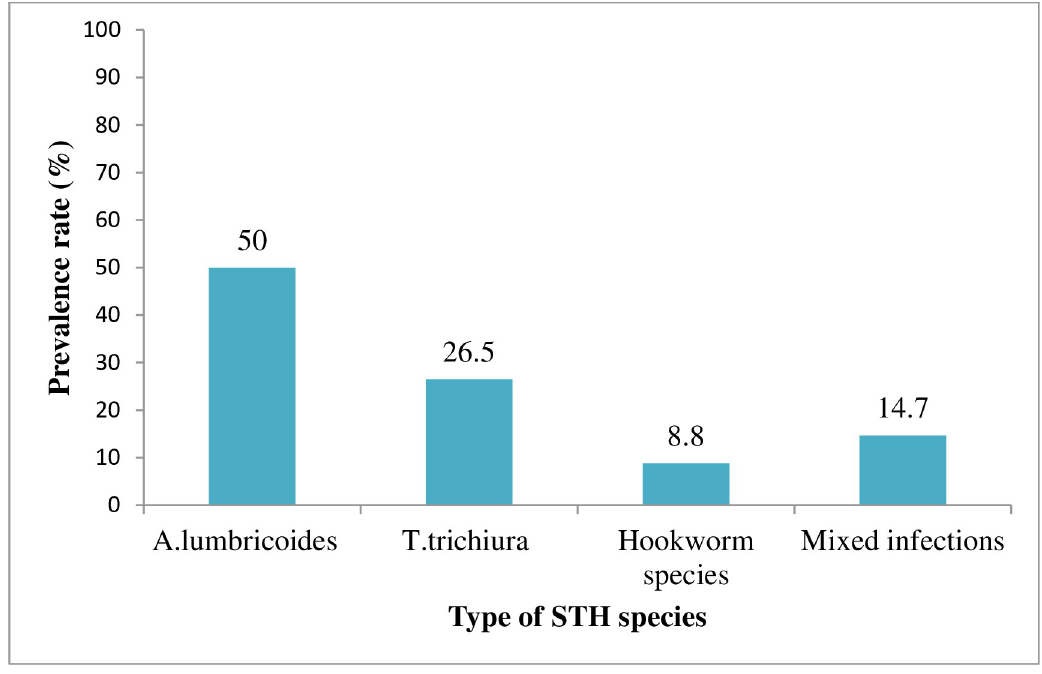
Fig 3. Prevalence of single and multiple STH species.